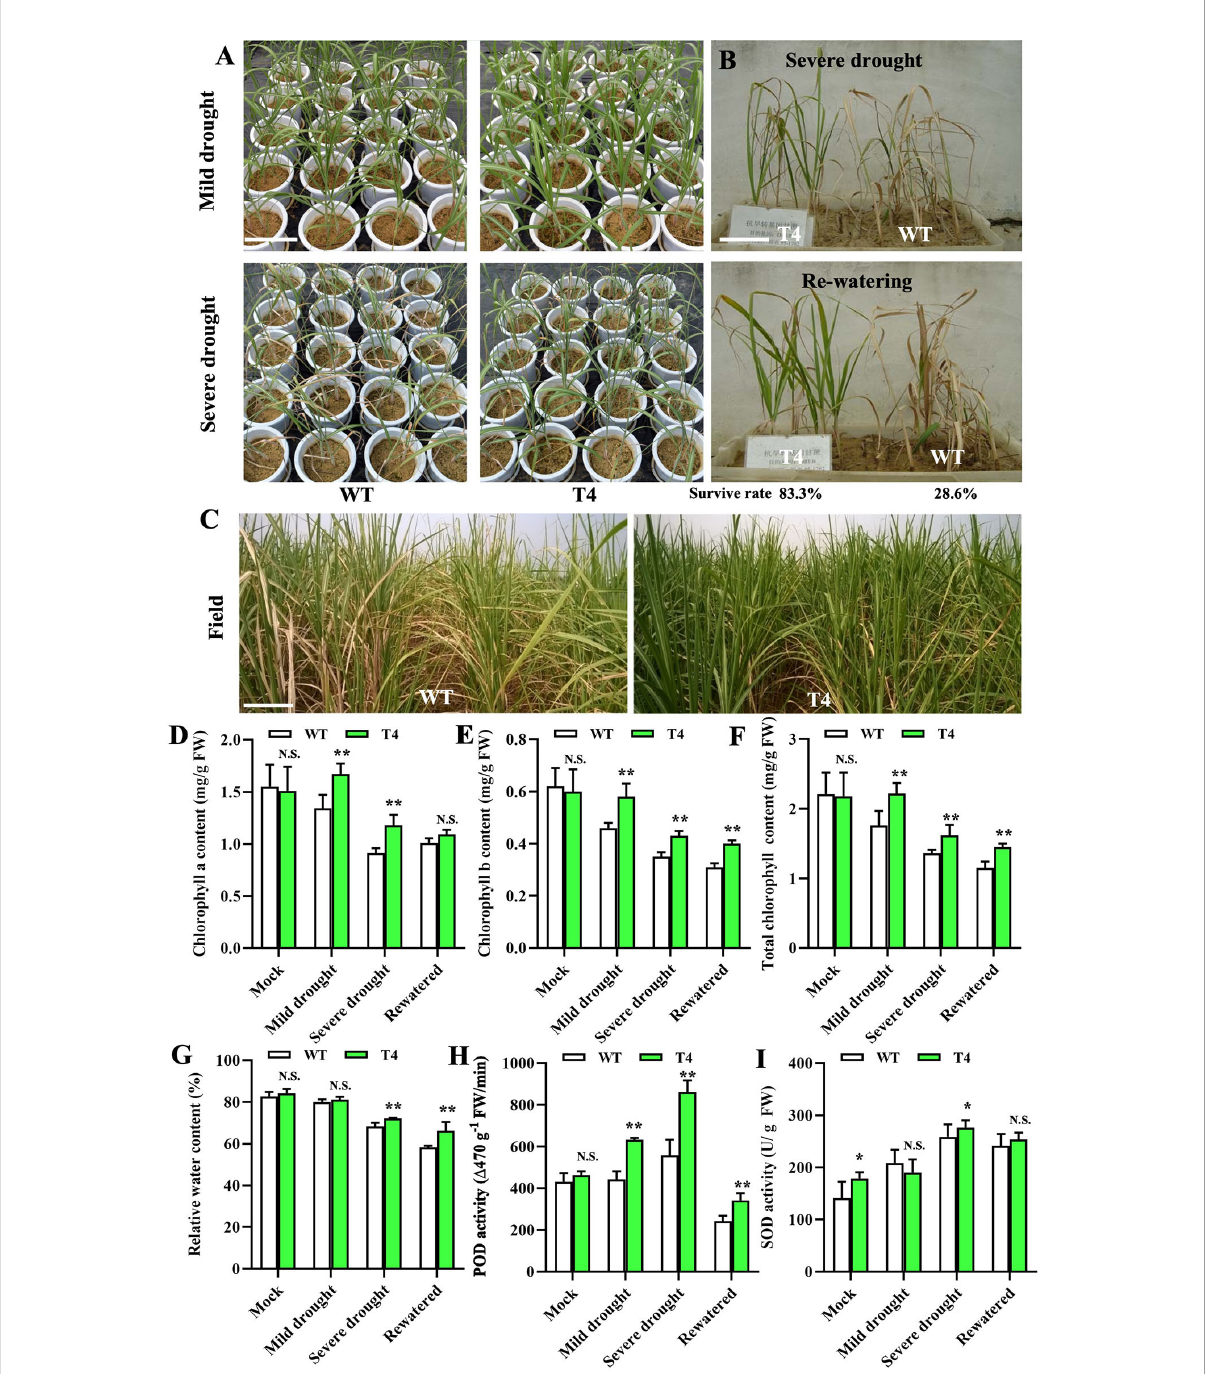
FIGURE 4 TaDREB2B increases drought tolerance in sugarcane in the fi eld. (A) Performance of wild type (WT) and Prd29A: TaDREB2B transgenic sugarcane seedlings under mild and severe drought conditions in the greenhouse. (B) The survival rate of WT and Prd29A: TaDREB2B transgenic seedlings planted in the same nursery pots under severe drought conditions and after re-watered treatment. (C) Performance of WT and Prd29A: TaDREB2B transgenic sugarcane under the water-limited condition in the fi eld. (D – I) The chlorophyll a content (D) , chlorophyll b content (E) , total chlorophyll content (F) , relative water content (G) , POD activity (H) , and SOD activity (I) of WT and Prd29A: TaDREB2B transgenic seedlings under different water-limited and re-watered conditions. The values are the means ± SD; n=6. All statistical analyses were performed using Student ’ s t -test: N.S., not signi fi cance; * P < 0.05; ** P <